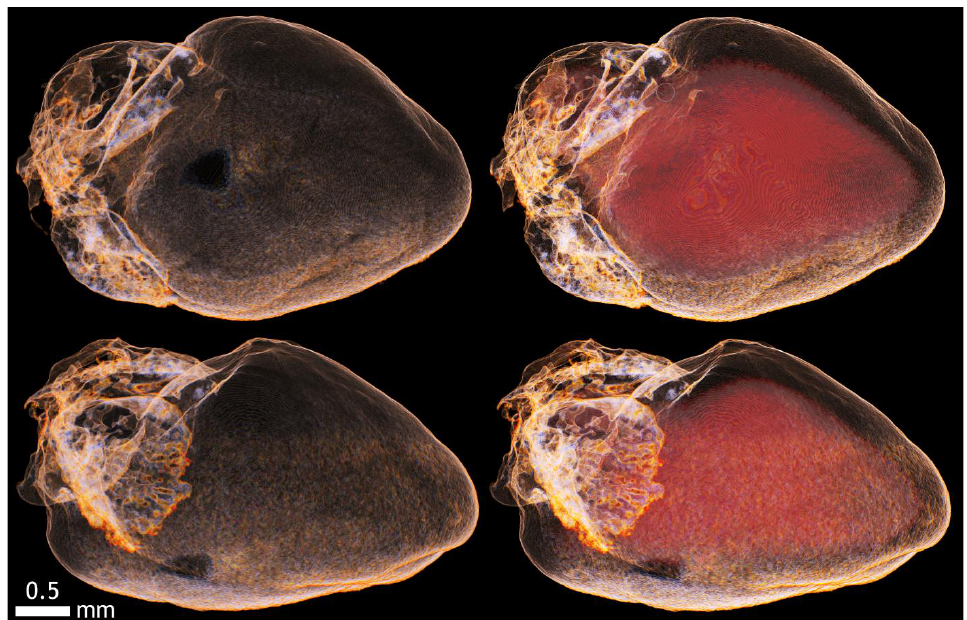
Figure A15. Imaging of the epicardium and endocardium of the heart and its cavities with KI and 20% ethanol.